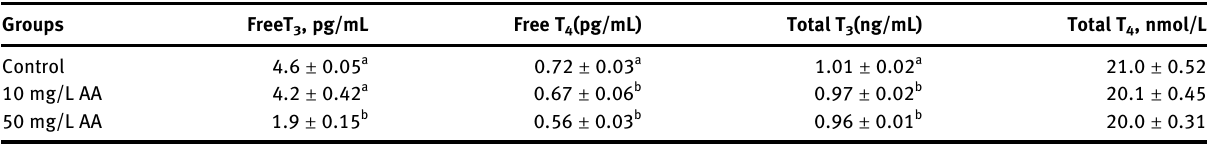
Table  : Serum total thyroxine (TT  ), total triiodothyronine (TT  ), free thyroxine (FT  ), free triiodothyronine (FT  ) levels of Cyprinus carpio , control and treatment groups exposed to  and  mg/L acrylamide (AA). (mean ± S.E.M.; n=  ).